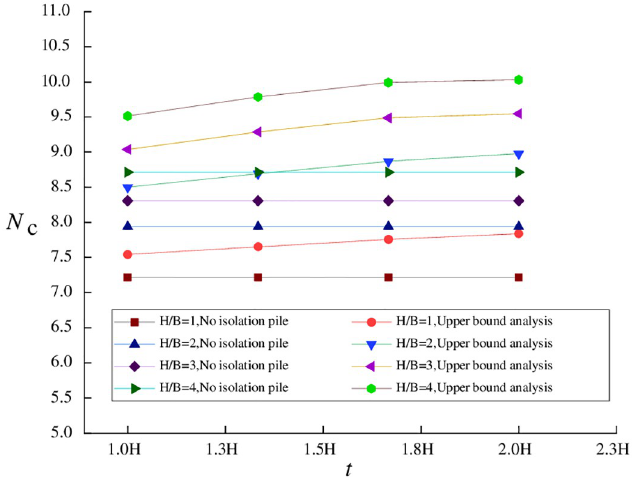
Fig 5. Relationship between stability coefficient and t ( e =